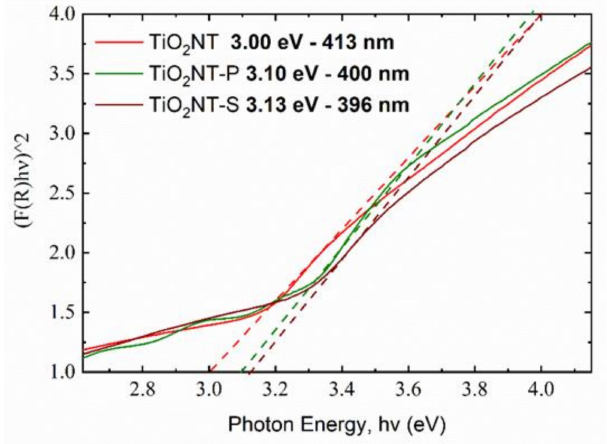
Figure 5. Tauc plots for the different nanotube